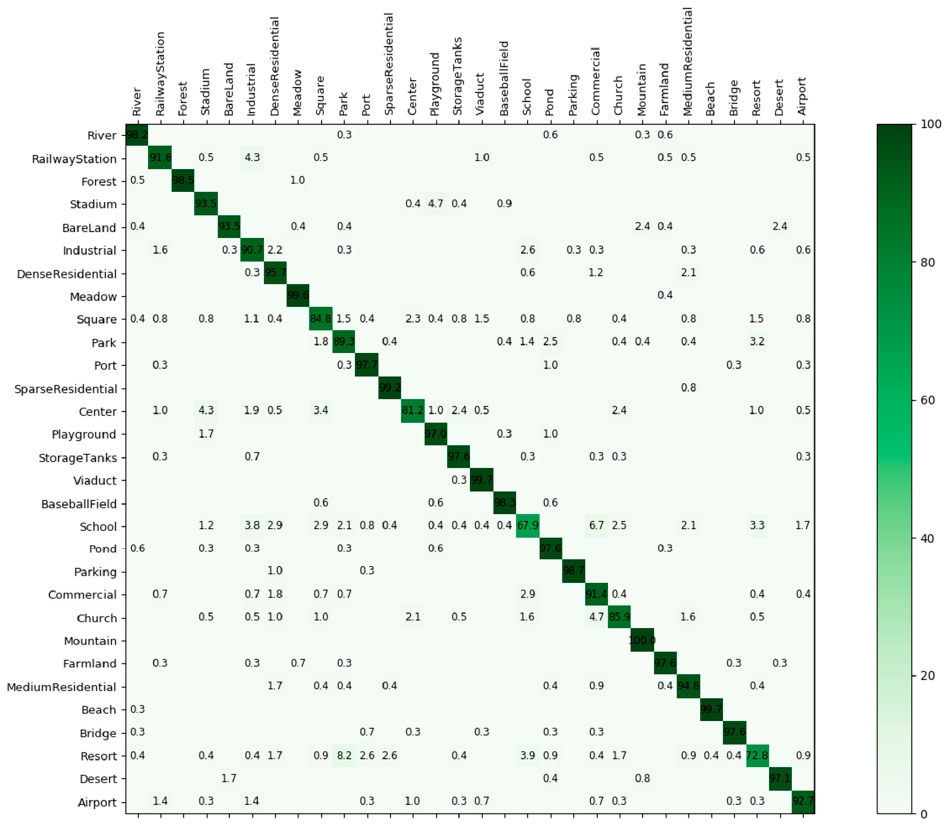
Figure 16. Confusion matrix of the proposed method on the AID dataset by fixing the training ratio as 20%.